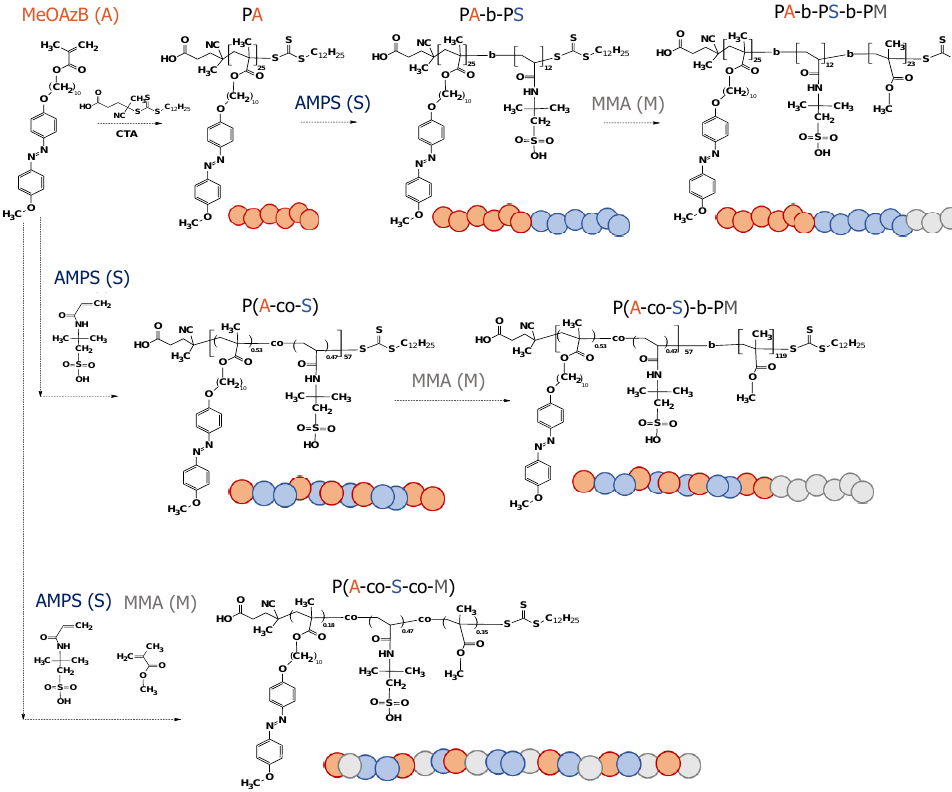
Figure 1. Chemical structure of the MeOAzB ( A ), AMPS ( S ) and MMA ( M ), monomeric units; synthetic routes of the polymers and copolymers prepared, and schematic representation of their monomers distributions.